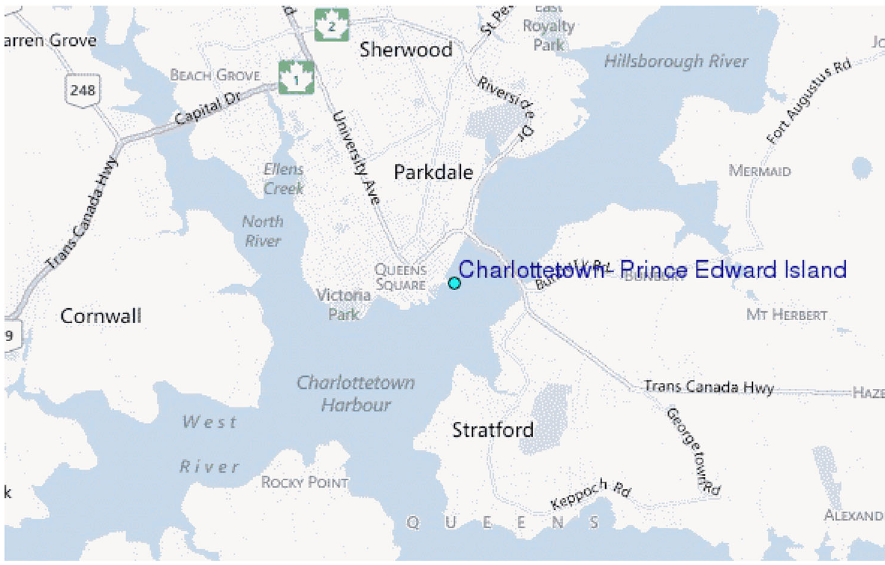
Fig. 1 City of Charlottetown, capital of Prince Edward Island, Canada, situated by the confluence of the West River, North River, and Hillsborough River in the central part of the island’s south shore. Source Reproduced with permission from